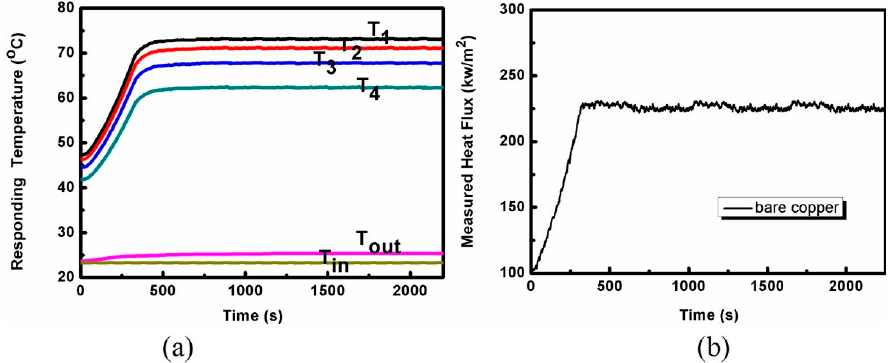
Figure 5. The responding temperatures and heat flux in heat transfer test. ( a ) The in-mold responding temperature time span; ( b ) the heat flux for bare copper system under thermal radiation.